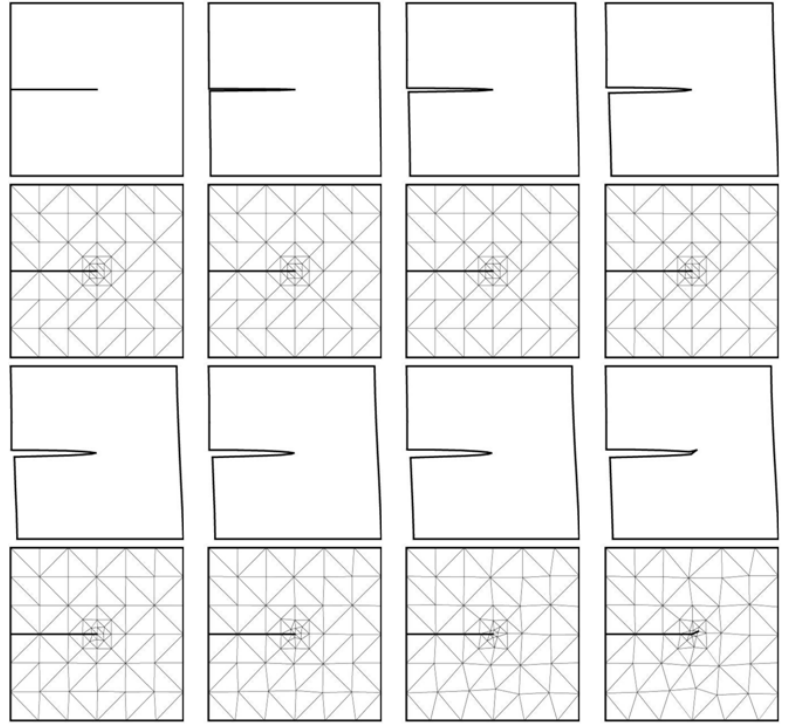
Figure 21: Kinking of a straight crack in mixed mode I & II. Refined mesh, mesh size: L/48 2 . Minimal deformation and modified mesh at 8 time steps. Crack kinking in the last